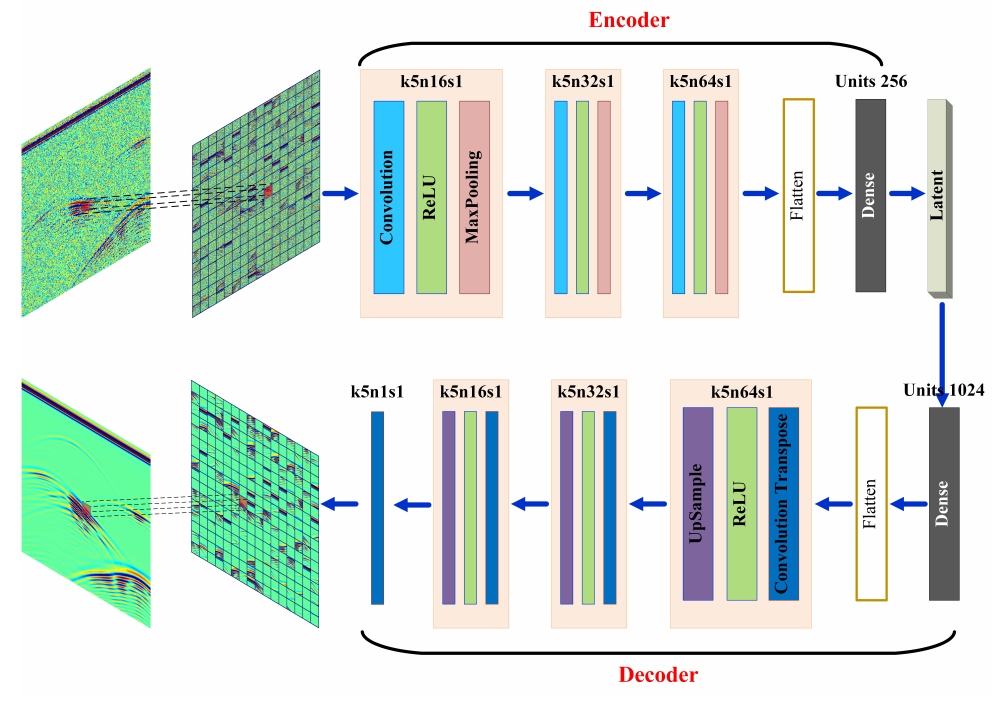
Figure 3. Structure of